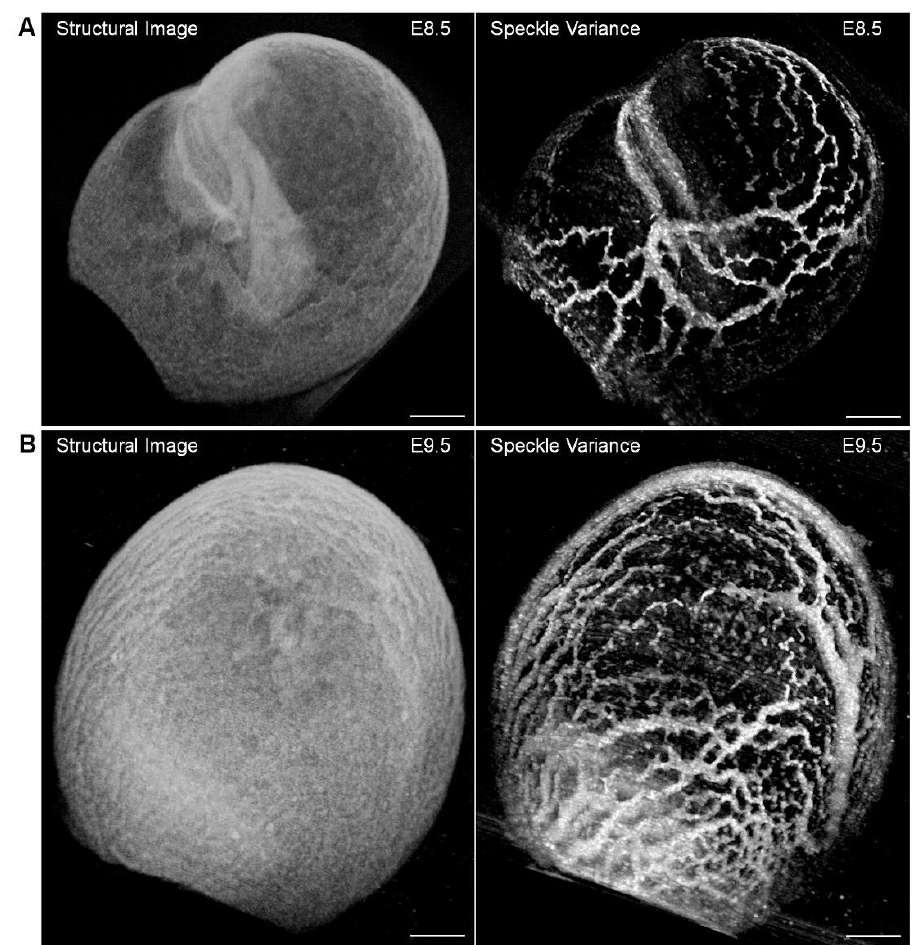
Figure 8. Visualizing the embryonic yolk sac vasculature with structural OCT ( left ) and SV OCT ( right ). Vascular remodeling from ( A ) E8.5 to ( B ) E9.5 is revealed from the speckle-variance (SV) contrast. Scale bars are 300 µm. Reproduced with permission from [77].